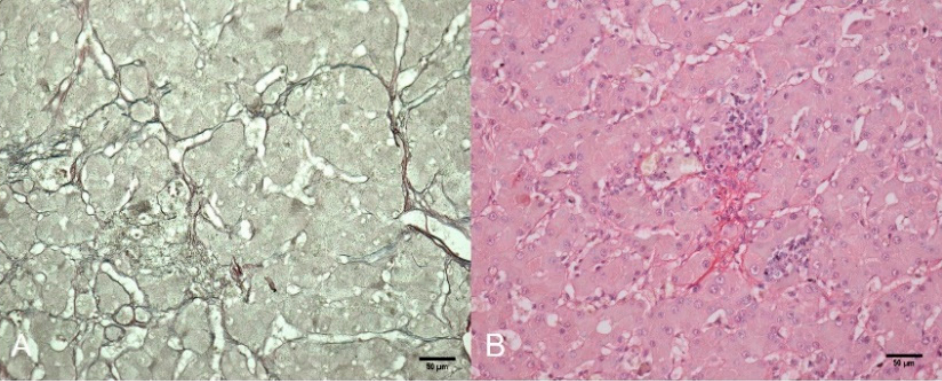
Figure 2. Hepatocellular carcinoma (HCC), liver, three-toed sloth ( Bradypus variegatus ). ( A ) Severe loss of reticulin framework in the thick trabeculae of neoplastic hepatocytes. Reticulin. Bar 50 µm. ( B ) Mild perisinusoidal and periductular fibrosis within the HCC lesion. Sirius red. Bar 50 µm.